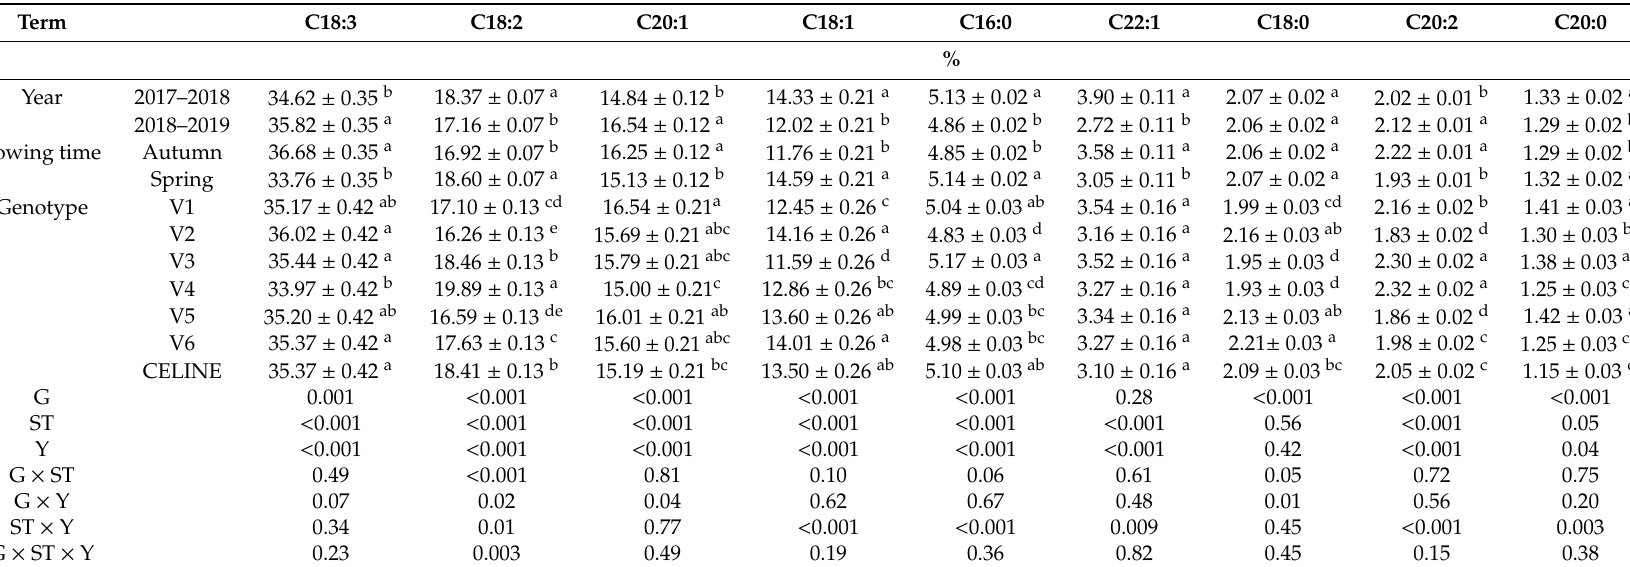
Table 5. Major fatty acids content (% of total FA) in camelina seeds in response to genotype (G), sowing time (ST) and year